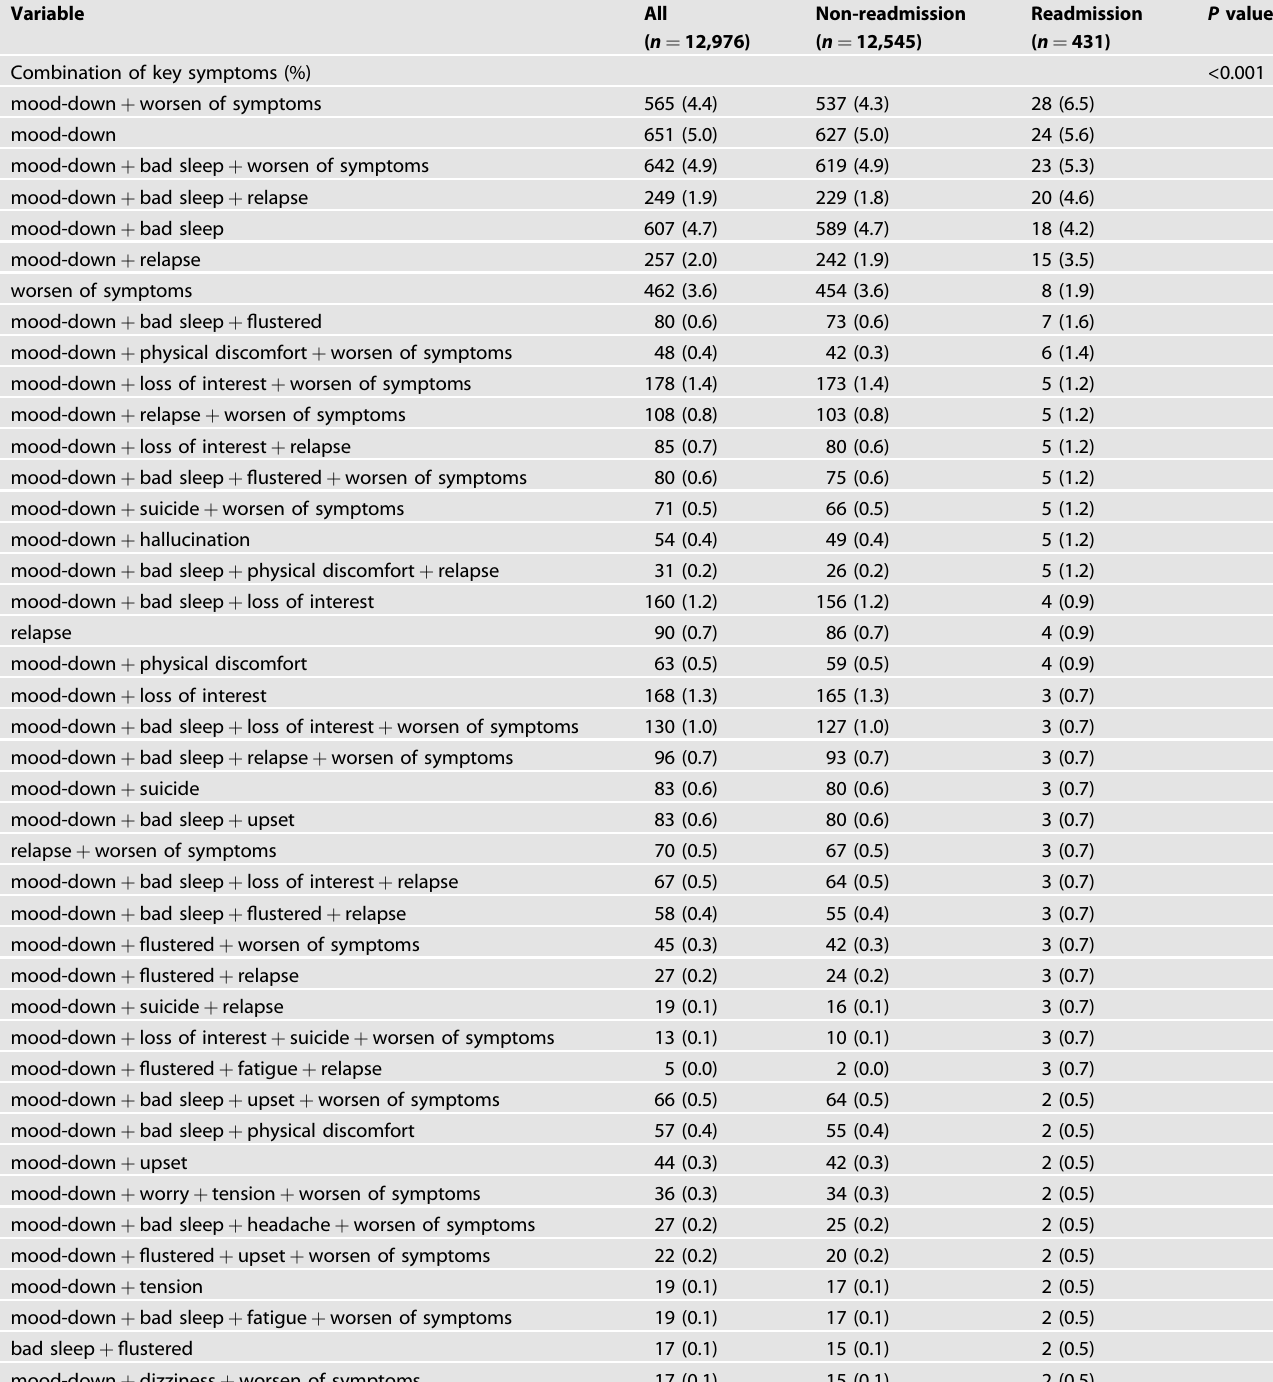
Table 2. Combination of key symptoms of the study